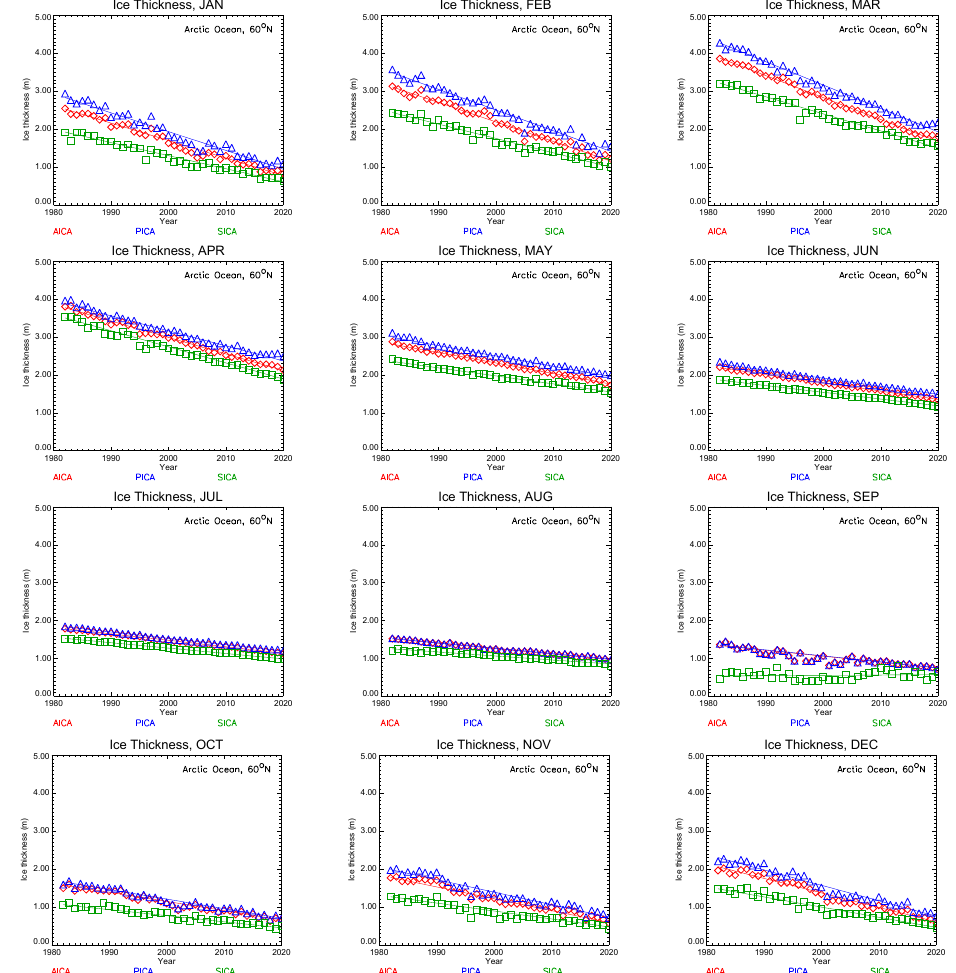
Figure 10. SIT time series for the Arctic area north of 60°N over 1982–2020 for the months of January through December. PICA (blue) stands for perennial ice-covered area, SICA (green) denotes seasonal ice-covered area, and AICA (red) designates all ice (PICA + SICA) covered areas.